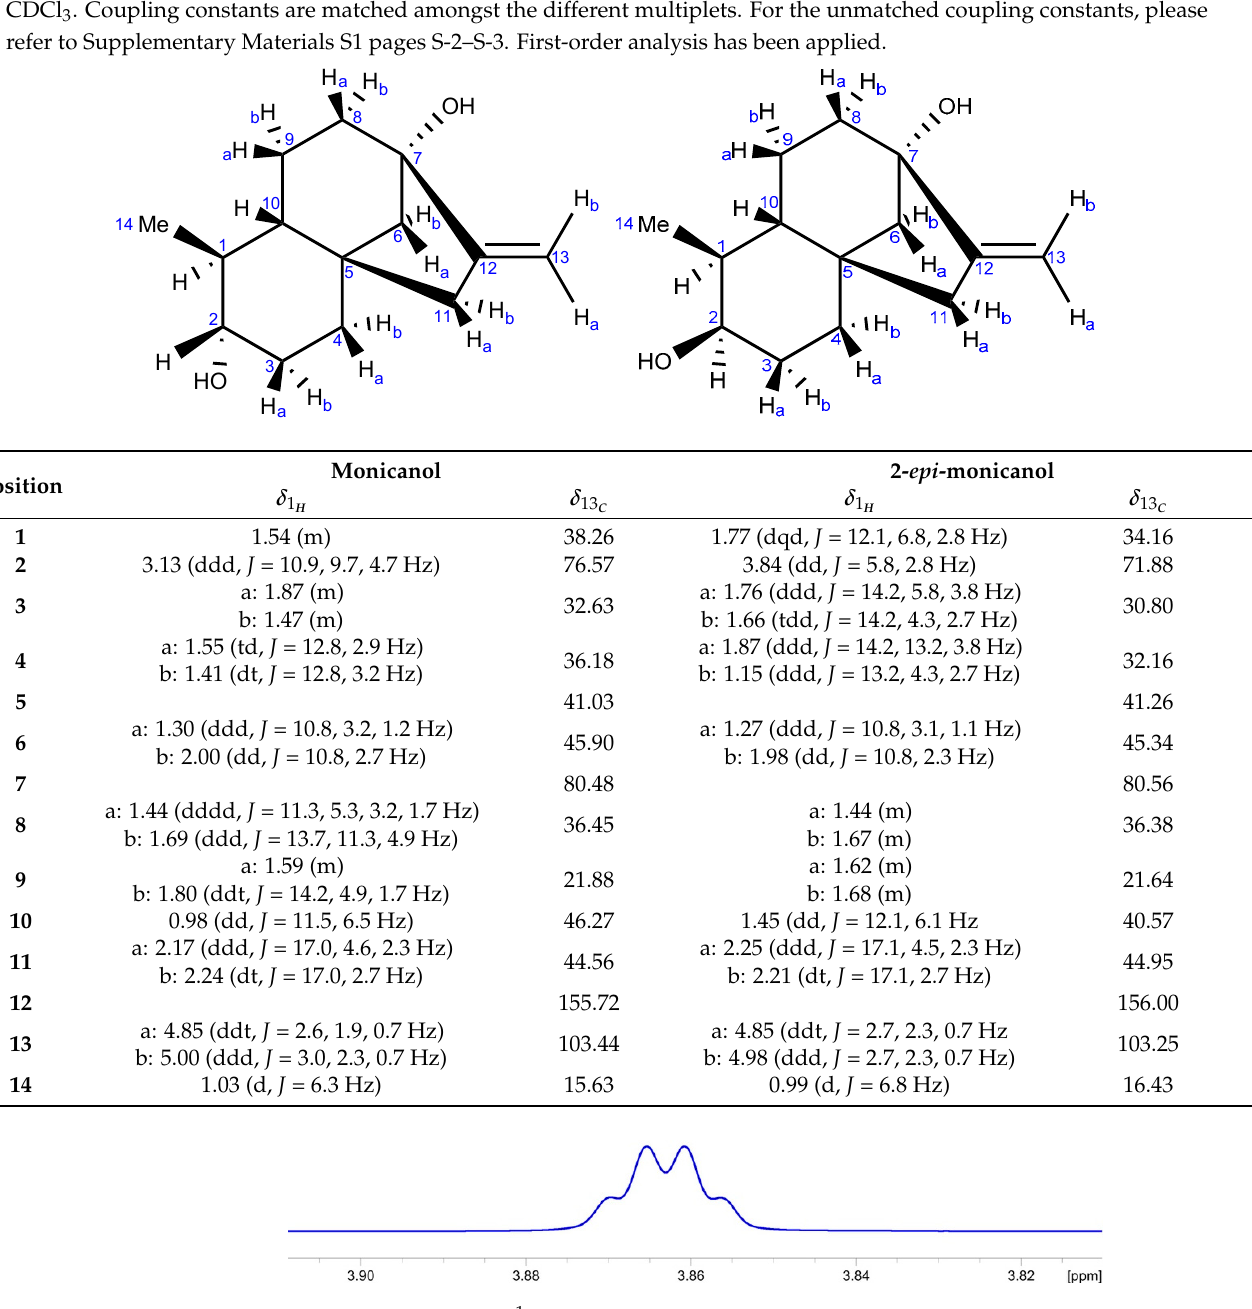
Figure 6. Experimental 1 H NMR multiplet pattern of H-2 of 2- epi